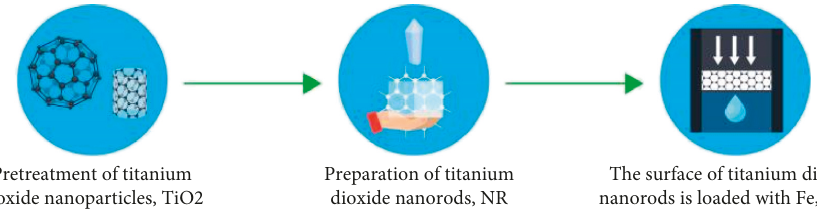
Figure 1: Chemical structure of free formaldehyde on nano-titanium dioxide Table 1: Reference formulation of nano-TiO 2 photocatalytic coating.